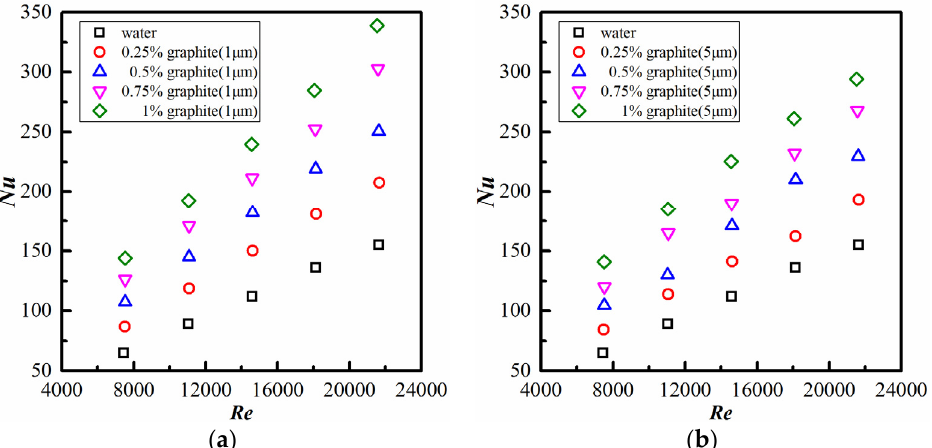
Figure 7. Relation diagram of Nu with Re : ( a ) a graphite particle size of 1 μ m; ( b ) a graphite particle size of 5 μ m.